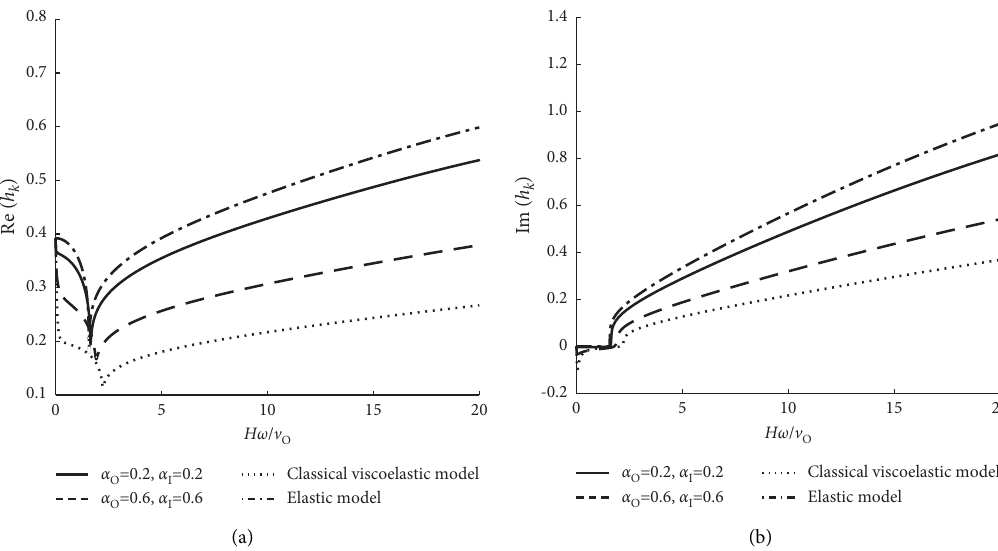
Figure 3: The first-order impedance factor curves of different soil models. (a) Horizontal stiffness factor of the soil layer. (b) Horizontal damping factor of the soil